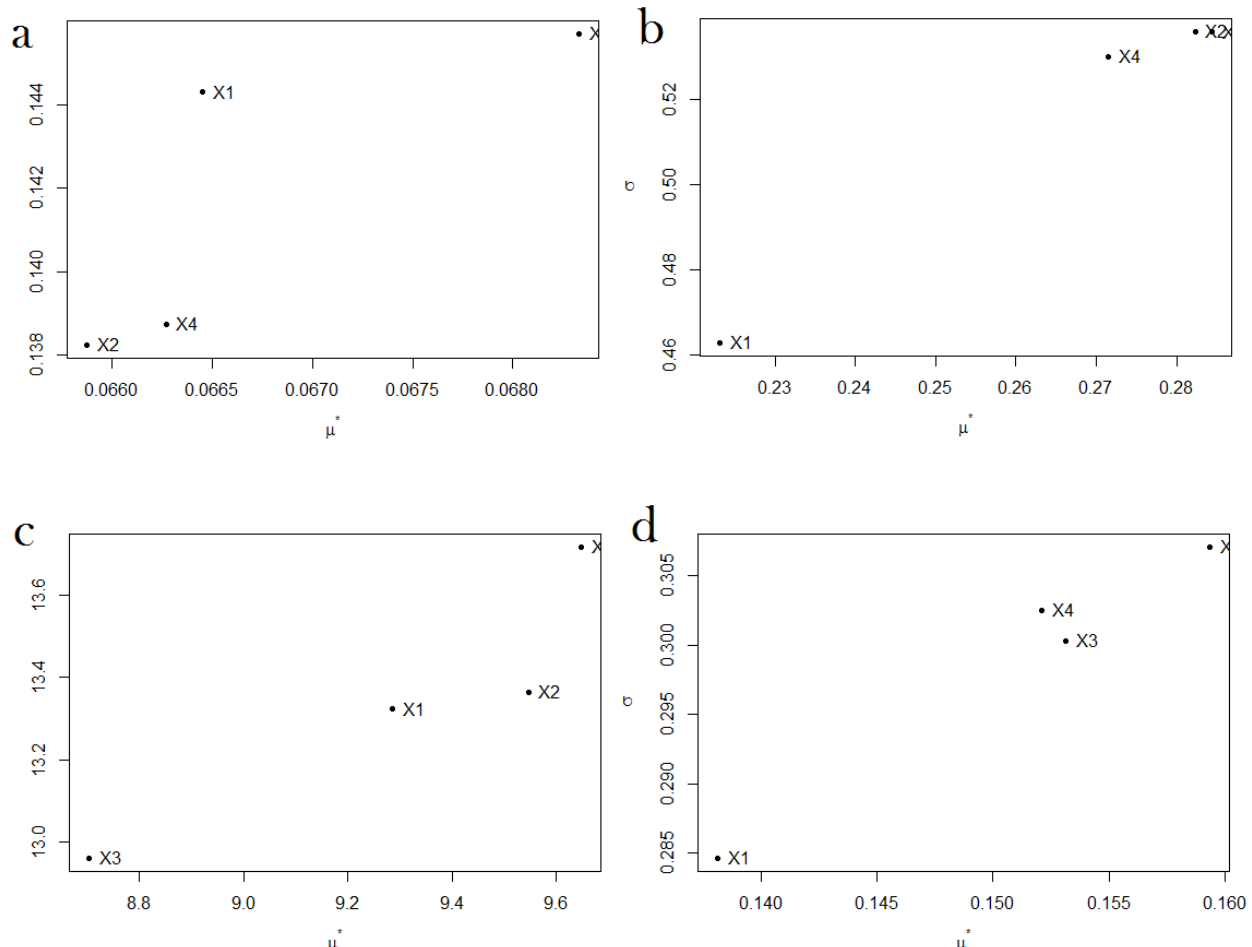
Figure 8. Mean and standard deviation of the distribution function of each parameter for the ecosystem health condition models using the Morris method for ( a ) 1990, ( b ) 2000, ( c ) 2018, and ( d ) 2028 (X1, X2, X3, and X4 represent NDVI, ESV, resilience, and fragmentation).